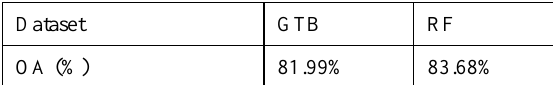
Table 4. Overall Accuracy by GTB and